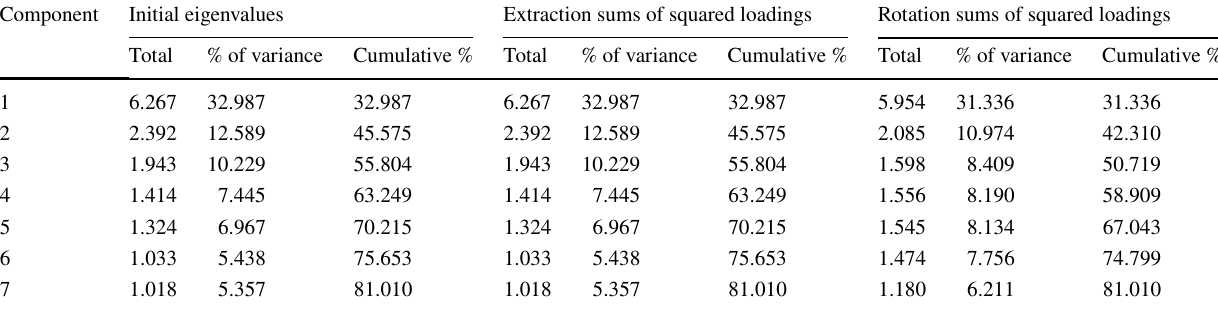
Table 2 Total variance and cumulative percentage of components